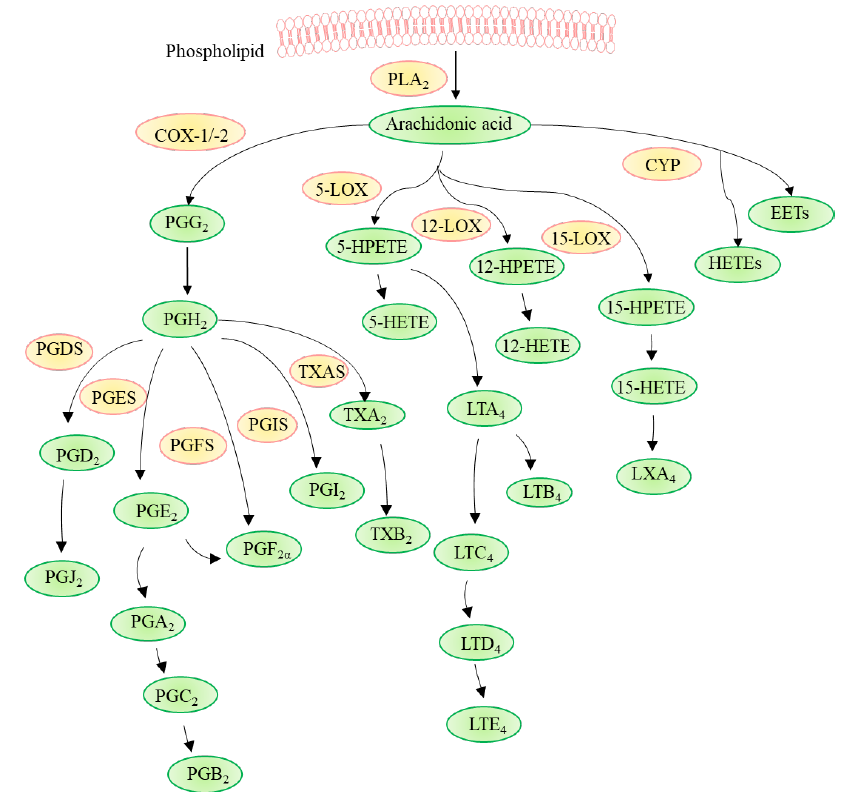
Figure 2. Arachidonic acid metabolism. Arachidonic acid is released from phospholipid by phos- pholipase A 2 (PLA 2 ) and, in turn, is metabolized through three different pathways involving cy- clooxygenase (COX), cytochrome P450 (CYP) enzymes, or lipoxygenase (LOX). COX-1 and COX-2 convert arachidonic acid to prostaglandin (PG)G2 and PGH2, which are further metabolized to various prostaglandins (PGs) such as PGD 2 , PGE 2 , PGF 2 α , prostacyclin (PGI 2 ), and thromboxanes (TX)A 2 by corresponding synthases, i.e., PGD 2 synthase (PGDS), PGE 2 synthase (PGES), PGF 2 α synthase (PGFS), PGI 2 synthase (PGIS), and TXA 2 synthase (TXAS). LOXs catalyze the dioxygenation of polyunsaturated fatty acids to their corresponding hydroperoxyeicosatetraenoic acids (HPETEs), which are subsequently converted to hydroxyeicosatetraenoic acids (HETEs), leukotrienes (LTs), and lipoxins (LXs). CYP generates HETEs and epoxyeicosatrienoic acids